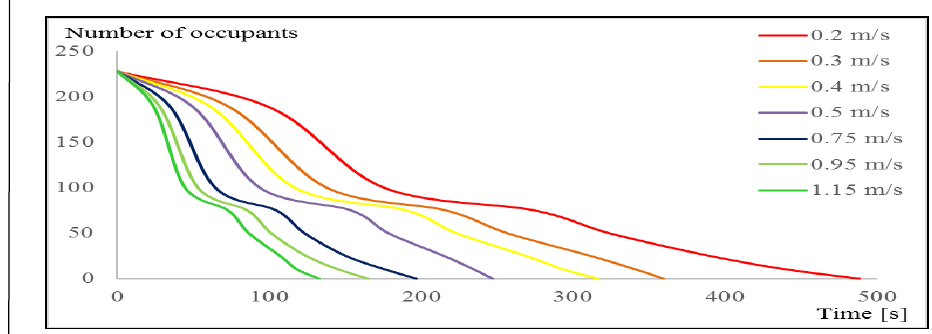
Figure 10 – Simulation results for the third case of the first scenario Рис. 10 – Результаты моделирования третьего случая по первому сценарию Слика 10 – Симулациони резултати за трећи случај првог